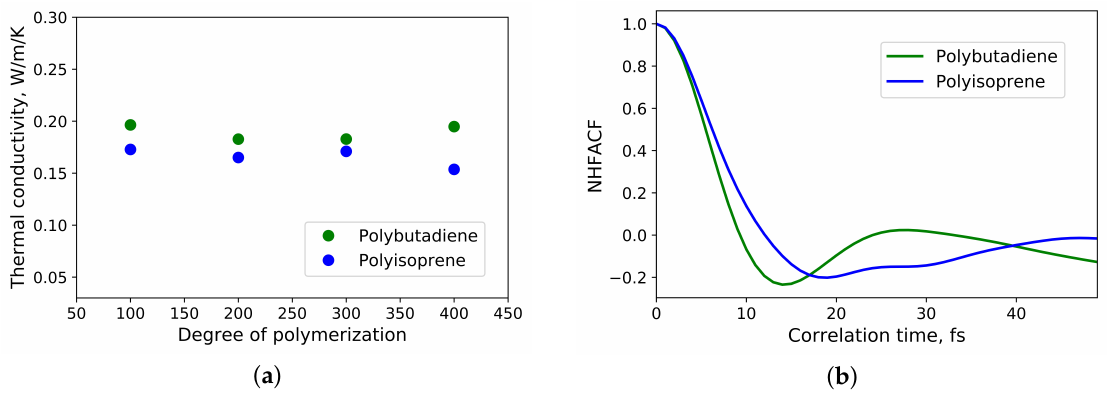
Figure 4. ( a ) Dependence of thermal conductivity of polyisoprene and polybutadiene from the degree of polymerisation and number of simulated atoms; ( b ) the first minima of the normalized heat flux autocorrelation functions of polyisoprene and